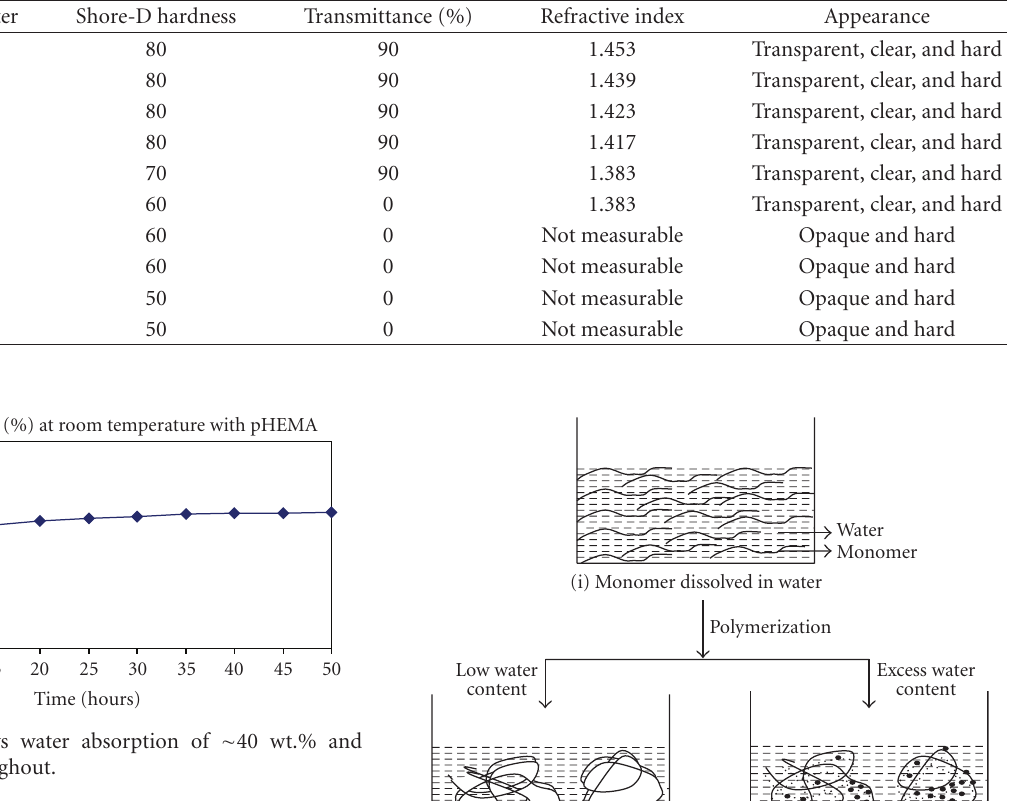
Table 2: Properties of HEMA polymerized in the presence of water.